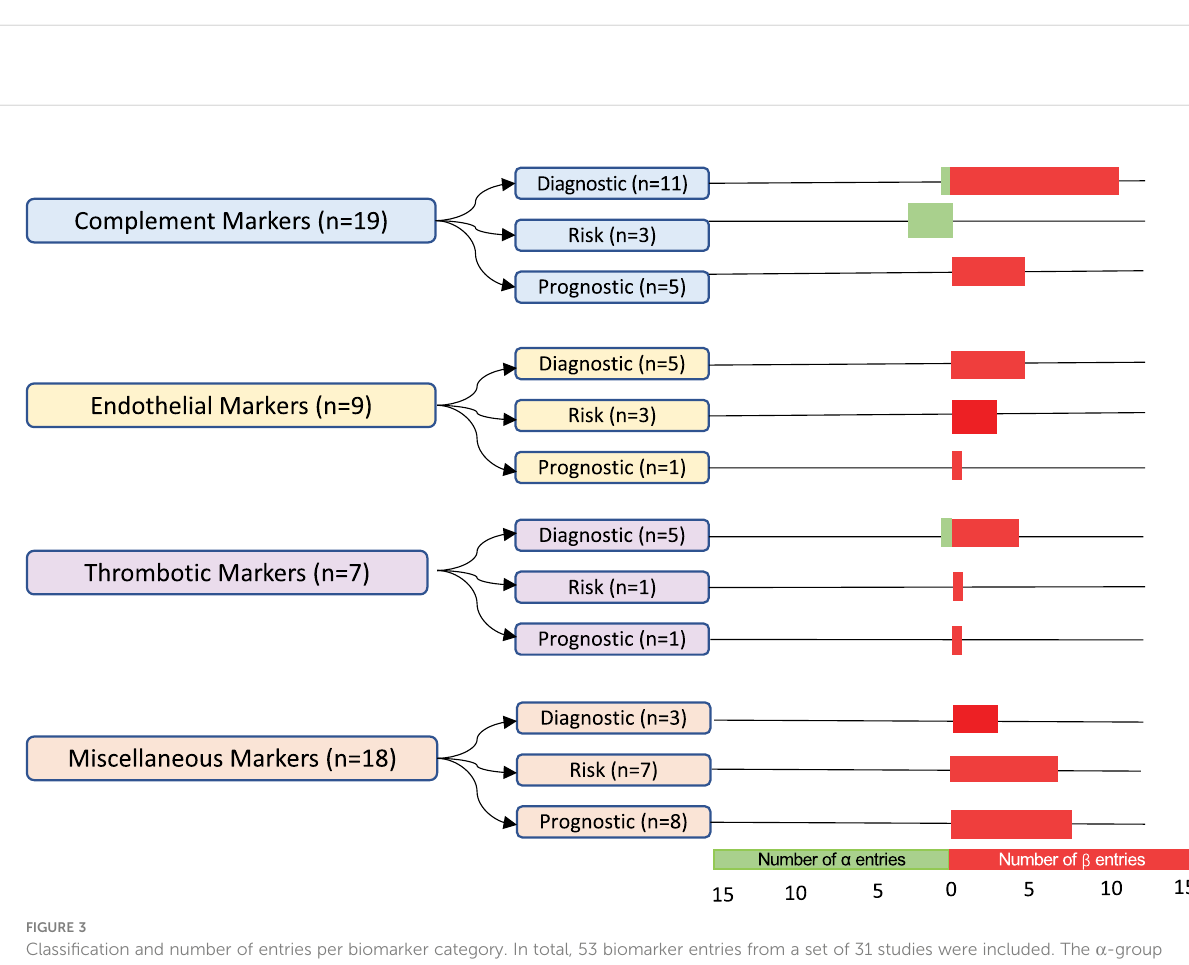
FIGURE 2 Summary of QUADAS-2 assessment for the risk of bias to assess study quality. Results of the QUADAS-2 questions for each study (n=31). If information was missing from the manuscript, it was indicated as unknown. In addition to typical QUADAS-2 questions, data for timing of diagnostic samples, validation cohort, and controls (whether the cohort was post HCT or healthy donors) are also indicated.